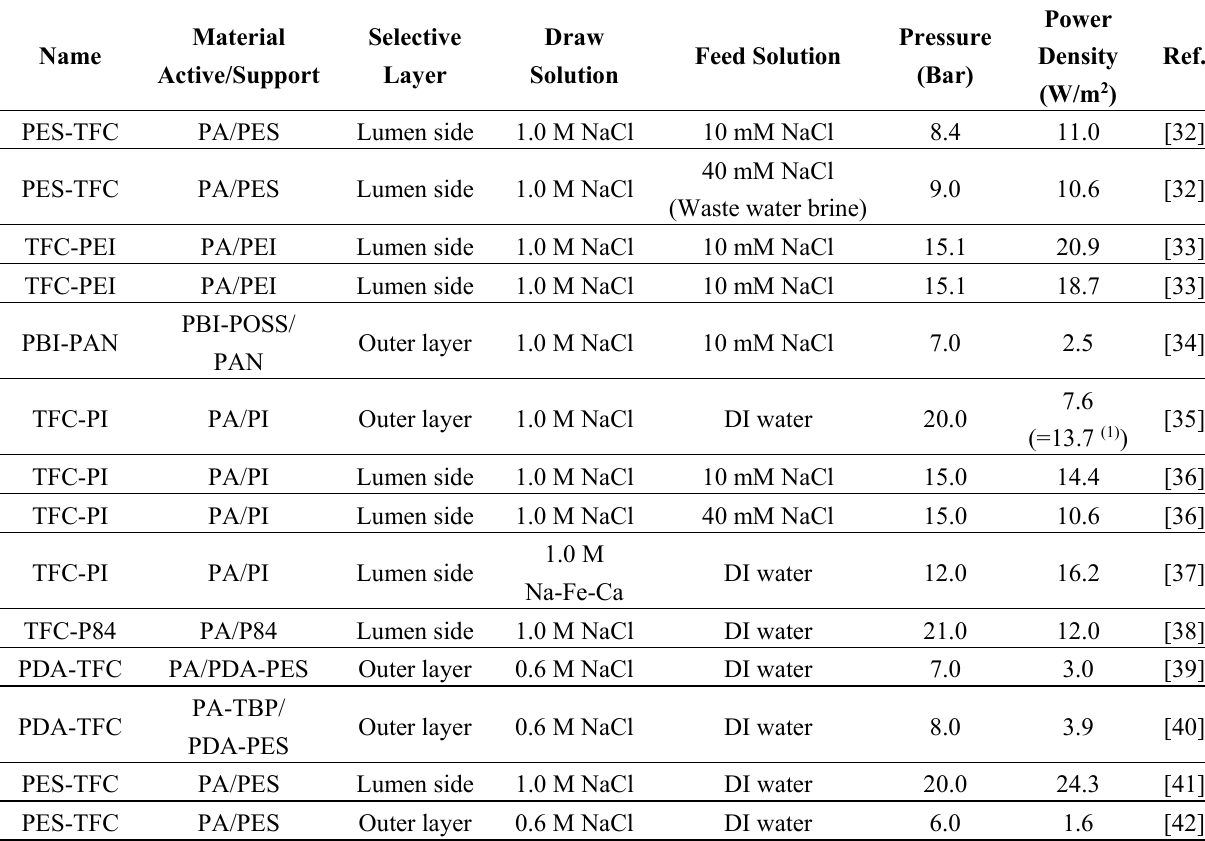
Table 2. Hollow-fiber membrane development for